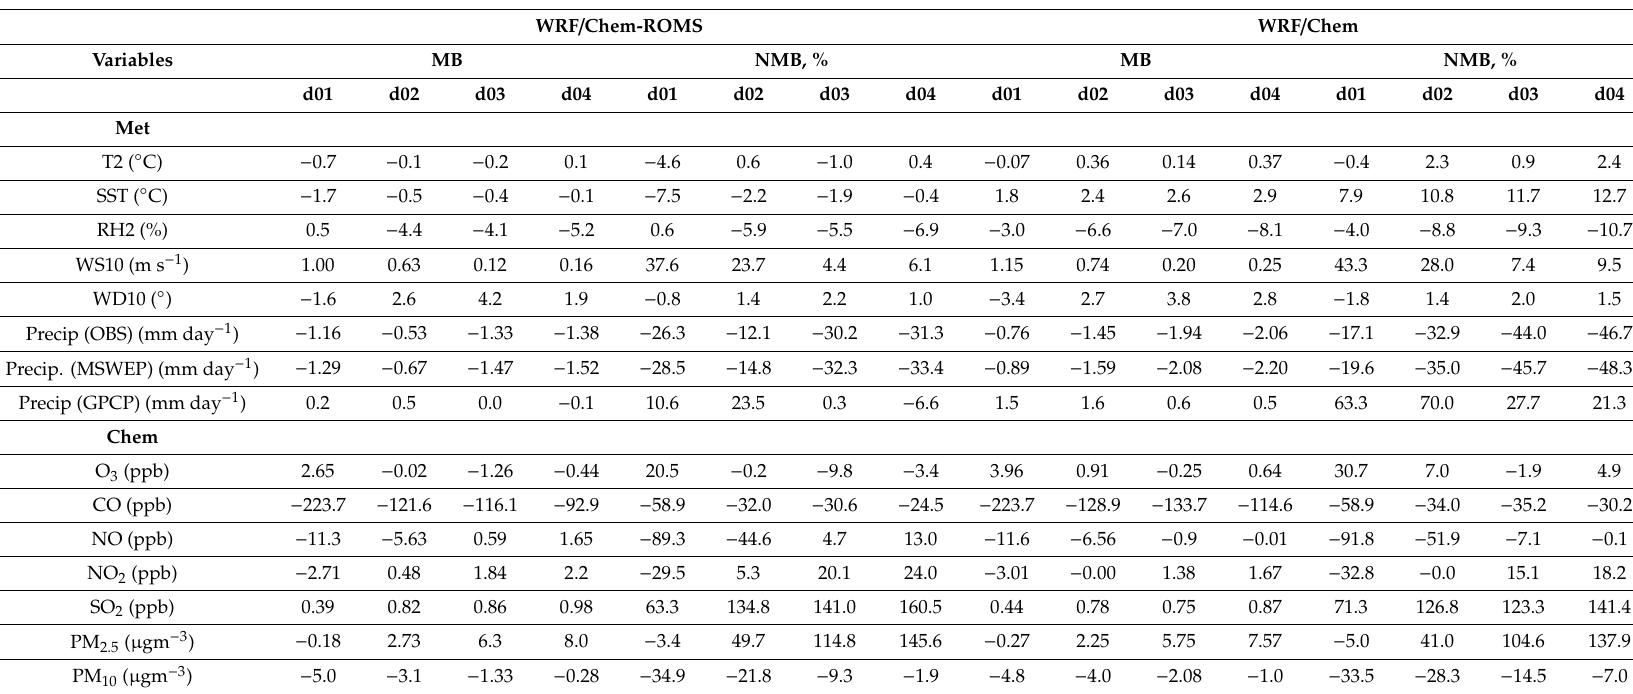
Table 2. Mean bias (MB) and normalized mean bias (NMB) of meteorological and chemical variables from WRF / Chem and WRF / Chem-ROMS simulations at 81 km (d01), 27 km (d02), 9 km (d03), and 3 km (d04) over the 3 km domain (d04) for the SPS2 field campaign. WRF / Chem-ROMS